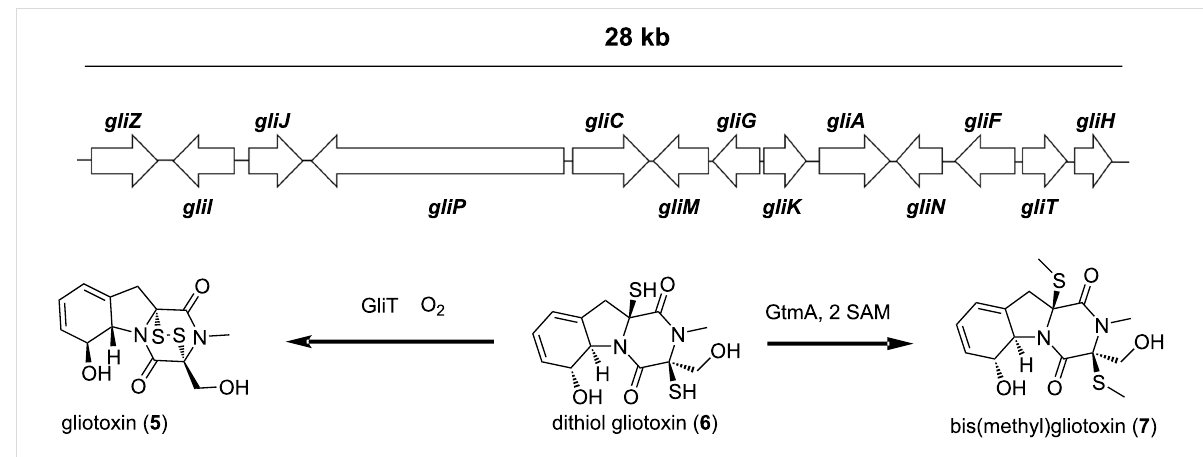
Figure 3: Gliotoxin biosynthetic gene cluster and it major biosynthetic transformations: Gliotoxin ( 5 ) is the oxidized form of dithiol-gliotoxin ( 6 ) cata- lysed by the gliotoxin oxidoreductase GliT. Dithiol-gliotoxin can be methylated to bis(methyl)gliotoxin ( 7 ) via the S-adenosyl-methionine (SAM) de- pendent bisthiomethyltransferase GtmA which is not part of the gli-